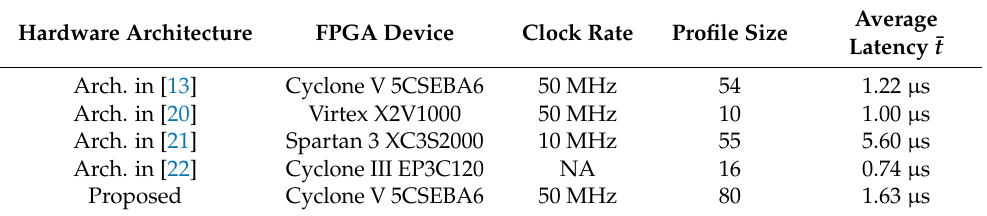
Table 5. The average latency ¯ t for a single prediction by various GRNN hardware